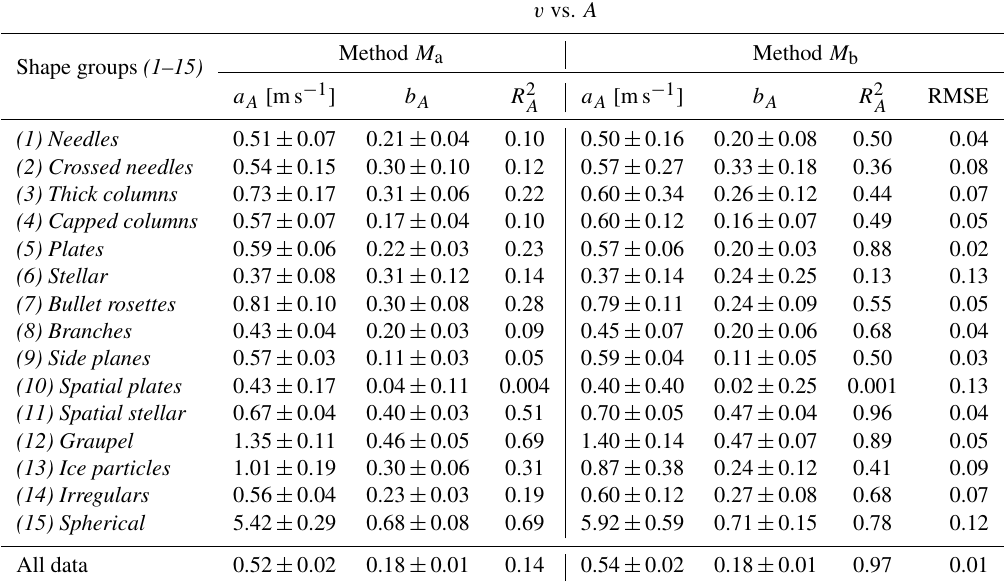
Table 4. Fall speed vs. cross-sectional area ( v vs. A ) relationships fitted to Eq. (5) for each shape group and for all data, i.e., for all the particles regardless of shape. The parameters a A , b A with their respective uncertainties and the correlation coefficients R 2 both methods ( M a and M b ) for each shape group and regardless of shape. The RMSE values of base-10 logarithms of measured v vs. predicted v are also shown to indicate the uncertainty of these power